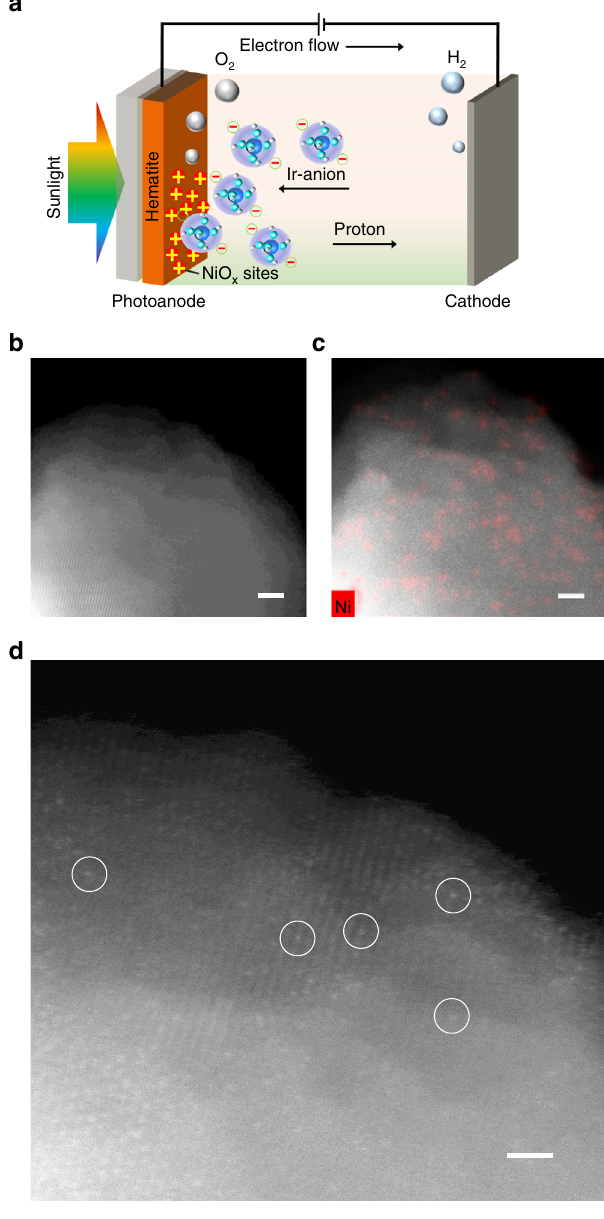
Fig. 1 Synthesis and HAADF STEM images. a Schematic illustration of the preparation process at 1.23 V RHE under AM 1.5 illumination in an electrolyte containing 1.0 M NaOH and 1.0 µ M Ir-anion. b High-resolution HAADF STEM image of the hematite-supported catalyst and c Ni EDX mapping. Scale bar, 2 nm. d Isolated Ir atoms exemplarily indicated by circles are dispersed on the hematite. Scale bar, 1